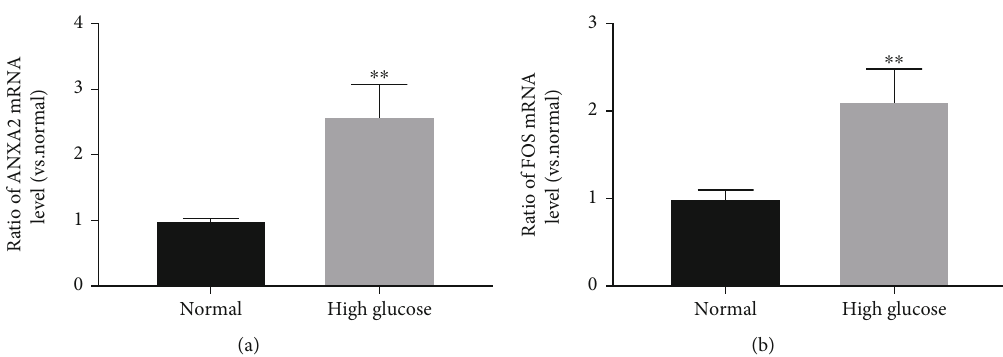
Figure 7: Validation of the expression level of three key genes using RT-qPCR in HK-2 cells under high-glucose stimulation: (a) ANXA2 and (b) FOS. ∗∗ P < 0 : 01 ; unpaired Student ’ s t